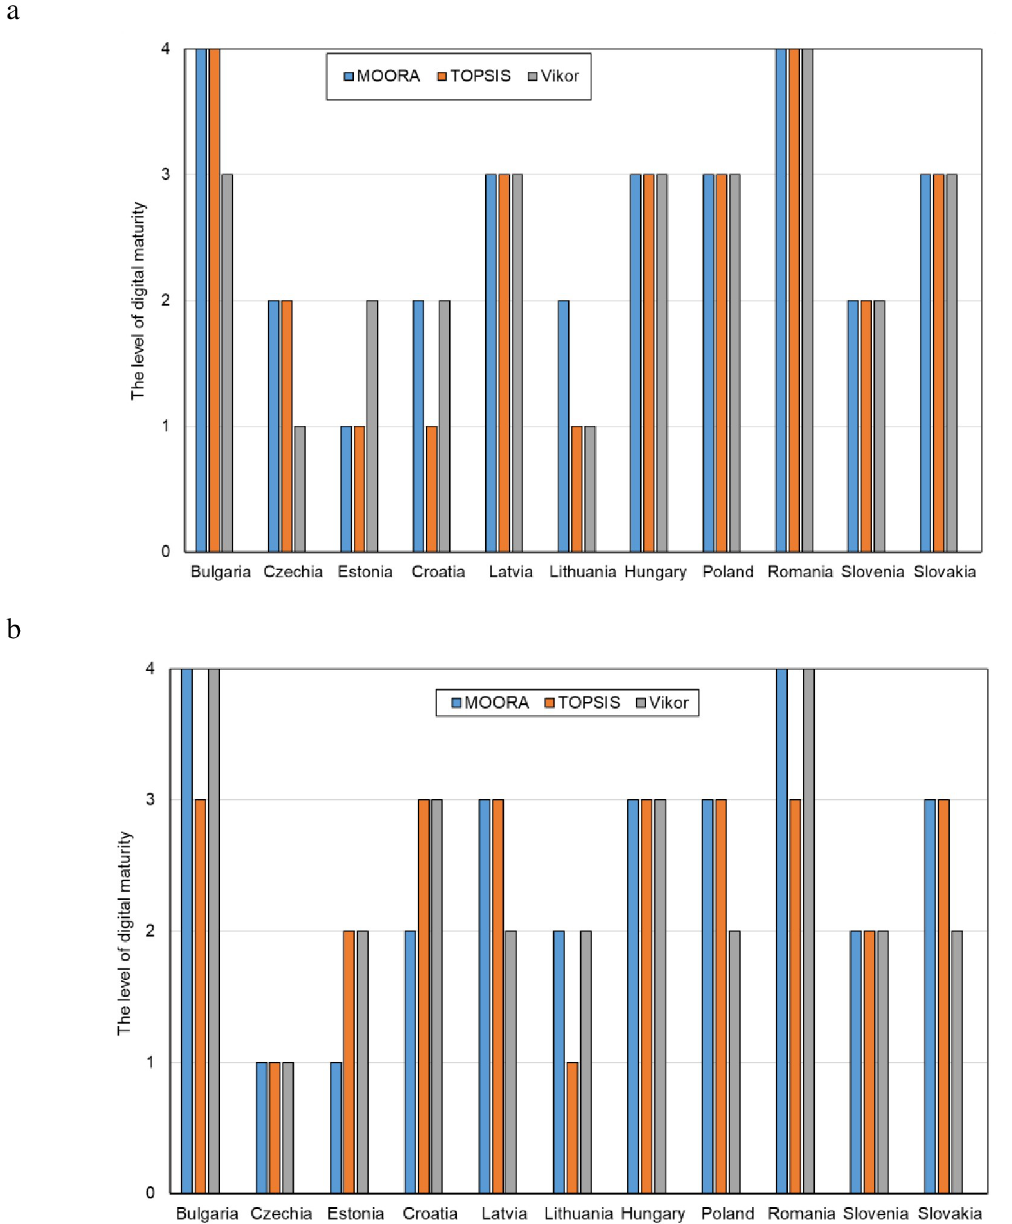
Fig 9. Assessment of the level of digital maturity among enterprises in the CEE countries (a–all enterprises, b– manufacturing enterprises) (1 –high level, 2 –average high level, 3 –average low level, 4 –low level).